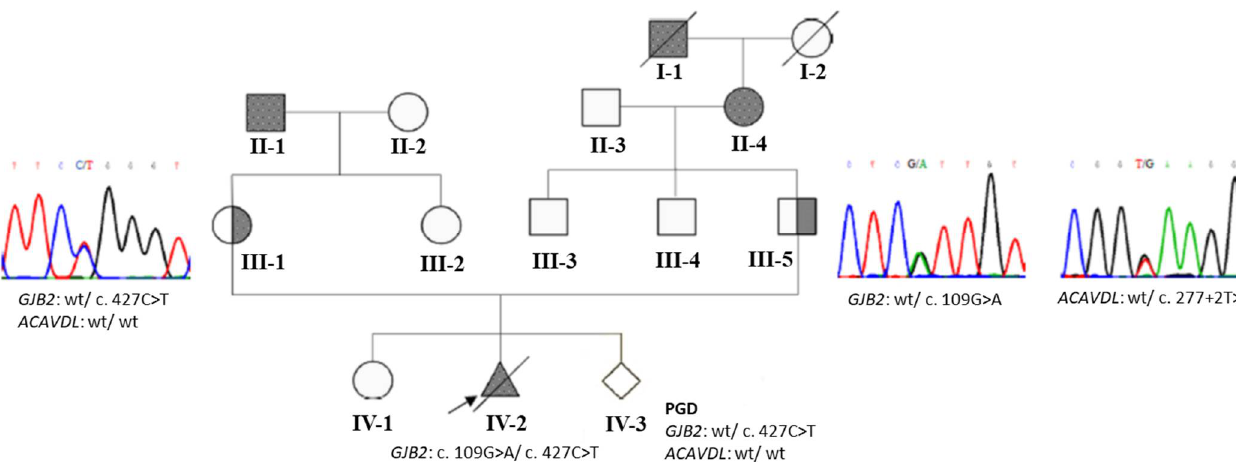
Figure 1. Pedigree and genotyping of an index family with GJB2 and ACADVL variants. The woman of the Case 9 couple (III-1) carried a heterozygous GJB2 c.427C>T variant, whereas the man (III-5) was heterozygous for the GJB2 c.109G>A variant, as well as heterozygous for ACADVL c.277+2T>G as an incidental finding. During their second pregnancy, they underwent whole exome sequencing for prenatal screening, which identified compound heterozygous GJB2 :c.[109G>A];[427C>T]. They used PGD and pregnancy was achieved after transferring one unaffected